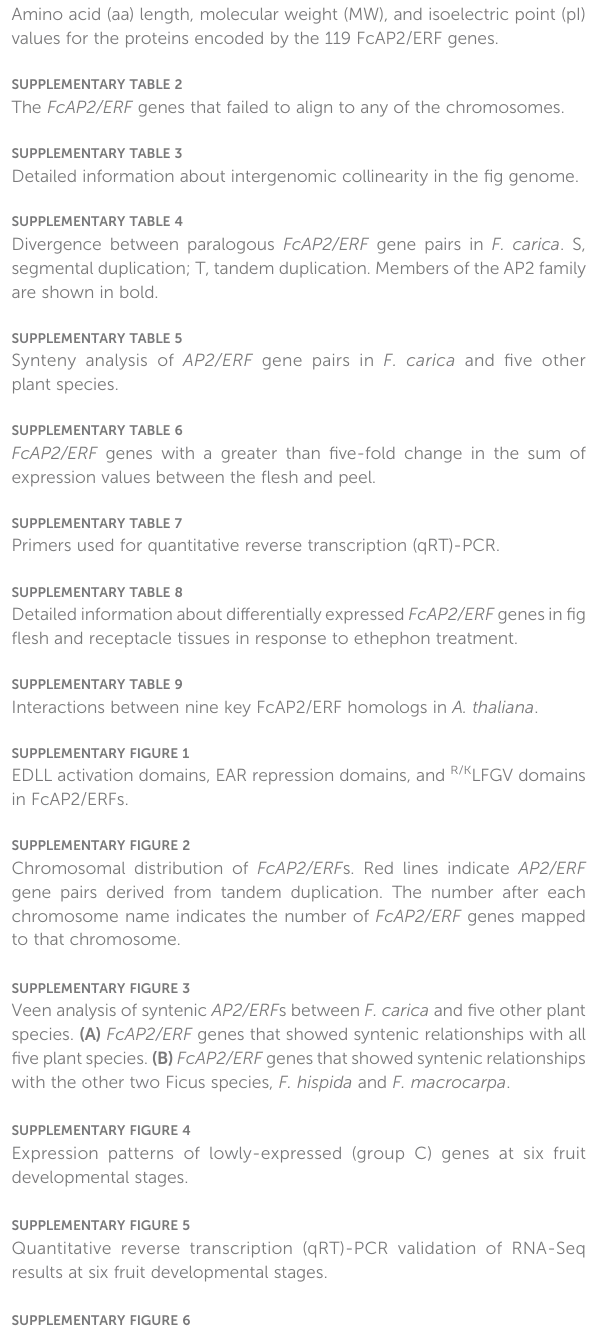
SUPPLEMENTARY FIGURE 7 AP2/ERF binding element in the promoter of pectate